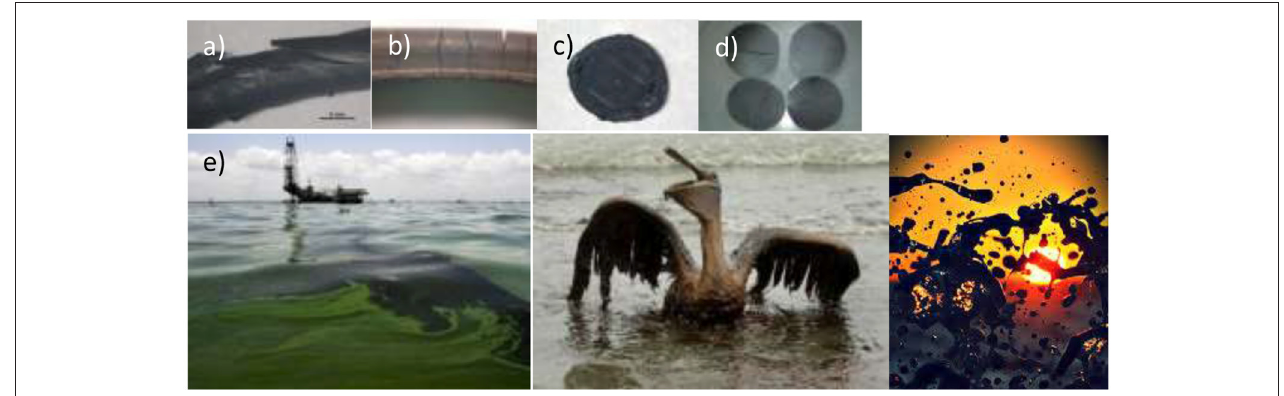
FIGURE 1 | Effects of operating severe conditions on traditional O-rings: (a) rupturing due to low mechanical strength to withstand the pressures and strains, (b) breaking due to low thermal stability, (c) resistance to excessive swelling behavior, (d) resistance to explosive decompression (courtesy of John Kerwin Precision Polymer Engineering Ltd). (e) Effects on the environment of O-ring breaking.